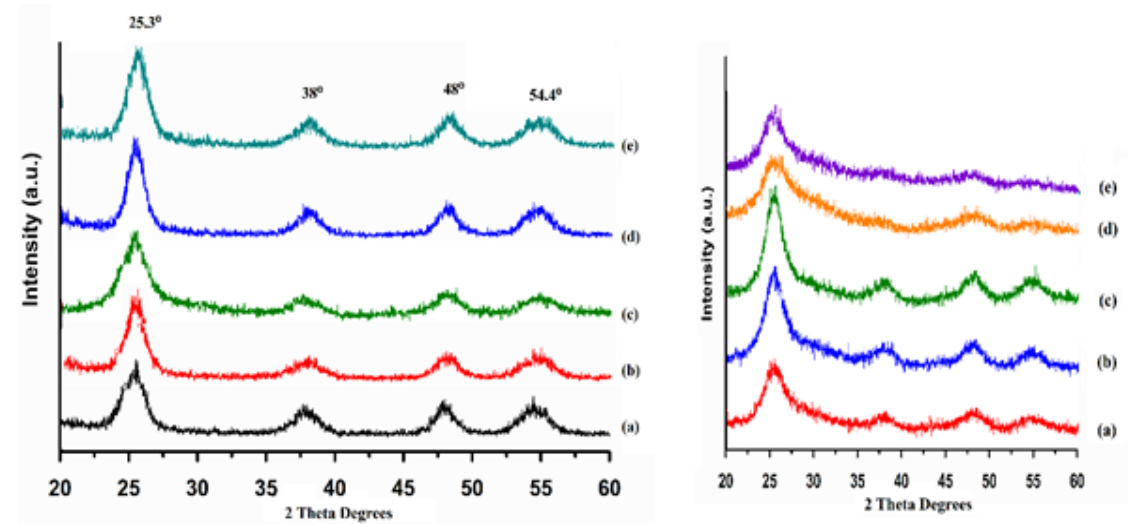
Figure 5. XRD spectra of ( a ) TiO 2 , ( b ) SiPc/TiO 2 , ( c ) ZnPc/TiO 2 , ( d ) CuPc/TiO 2 , and ( e ) CoPc/TiO 2 (( left ): without TX-100, ( right ): with TX-100).